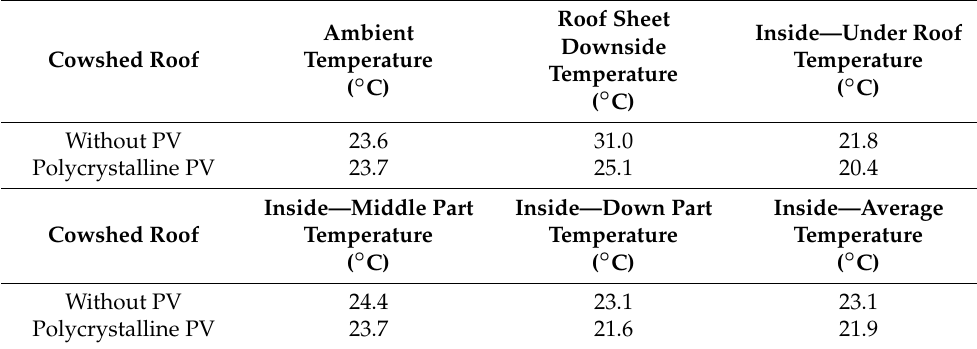
Table 2. Average temperatures calculated from measured data in real operating conditions of the cowshed.